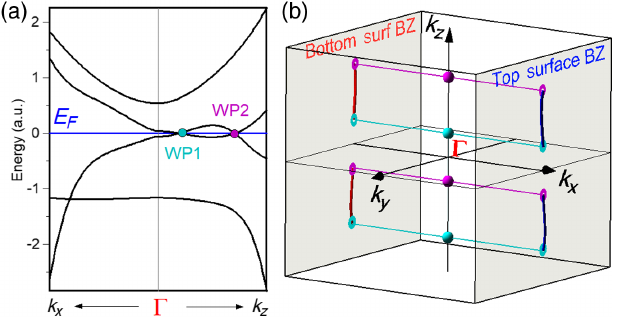
FIG. 6. (a) Dispersion of eigenstates of a 4 × 4 k (cid:3) p model used to illustrate the magnetization-induced Weyl semimetal state in UNiSn. The band structure is gapped for all k points in the BZ except along the Γ Z line, where the Weyl points are formed. (b) Position of the Weyl points in the BZ of the k (cid:3) p model periodized on the cubic lattice as well as shapes of the Fermi-arc surface states for the slab geometry with the normal along the x axis. Magenta refers to positive and cyan refers to negative chiral